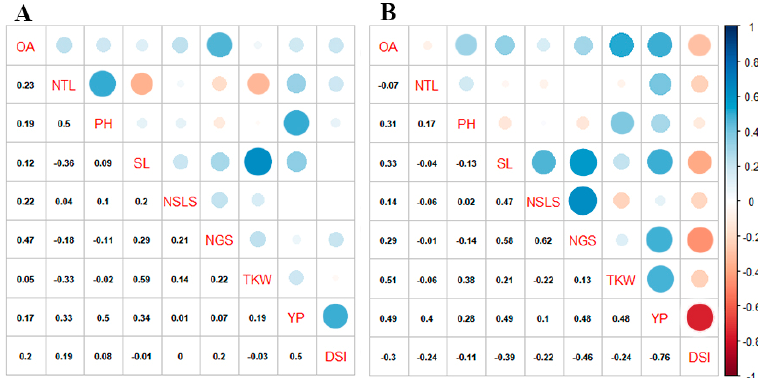
Figure 3. Correlation matrix between OA and yield traits. Left triangle ( A ) for WW and right ( B ) triangle for DS environment. Plants 2020 , 9 , x